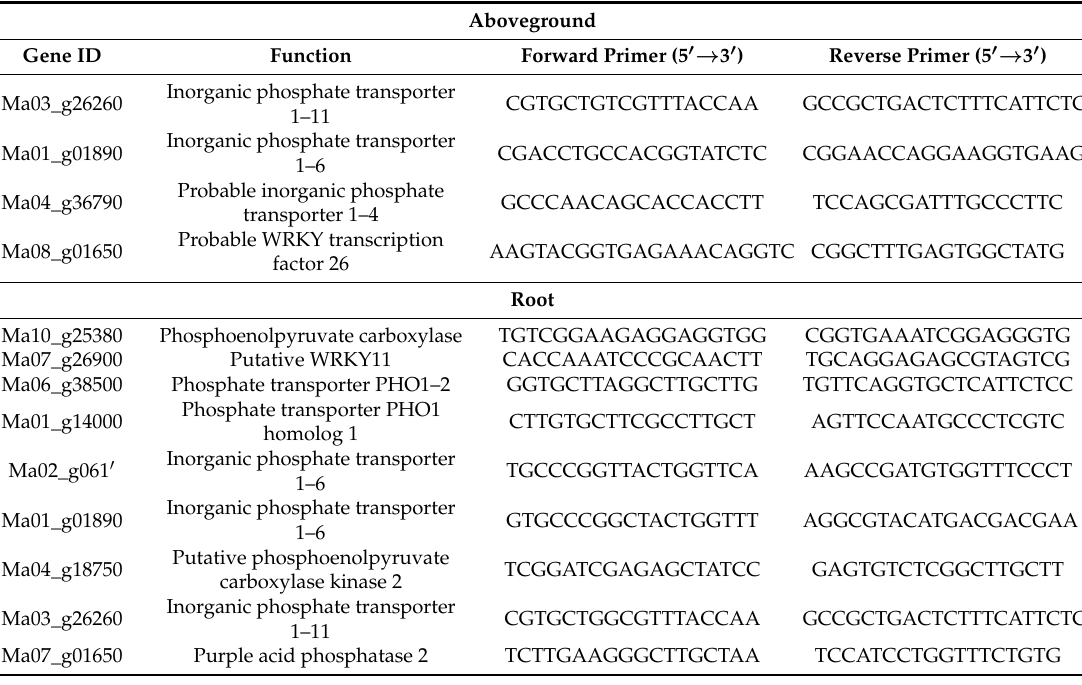
Table 6. Selected genes used for quantitative Reverse-Transcription PCR (qRT-PCR).